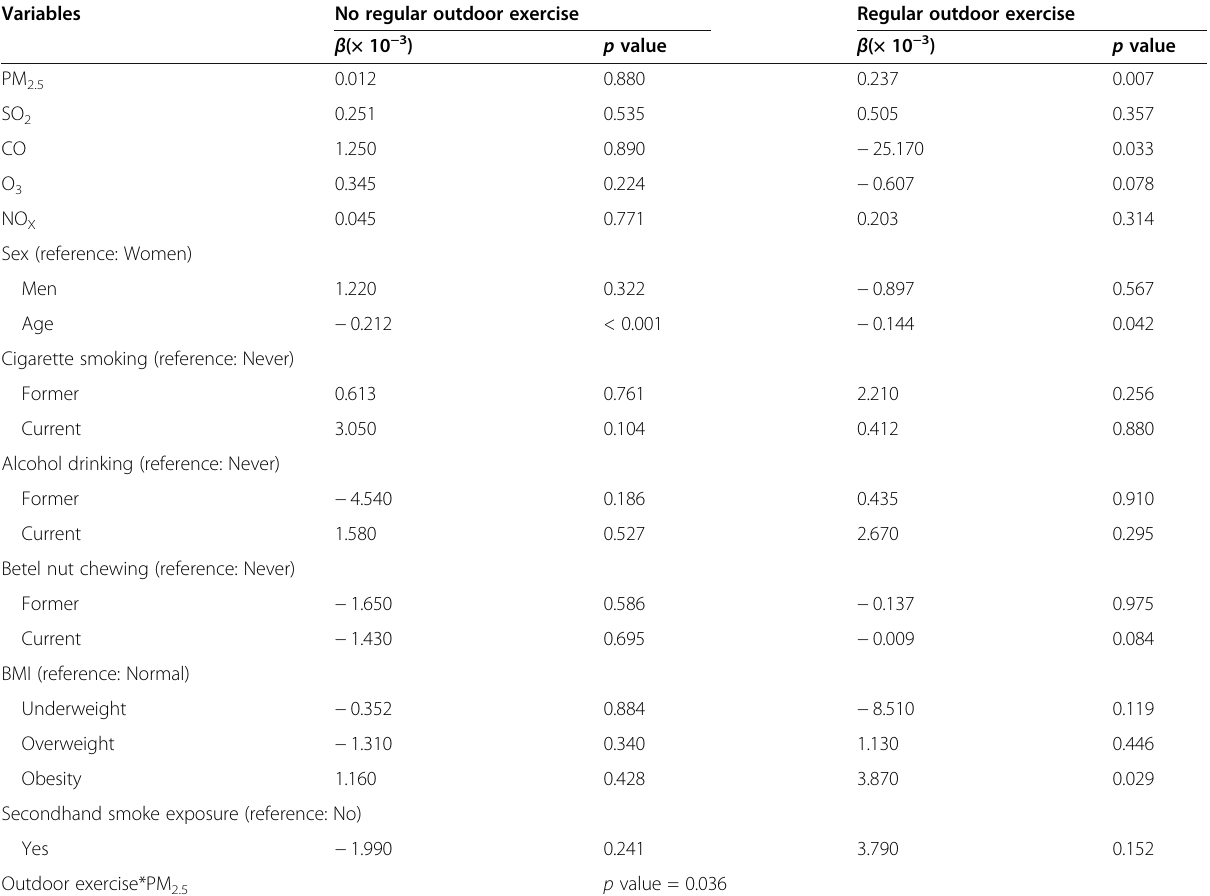
Table 3 Multiple linear regression showing the association between PM outdoor exercise habits